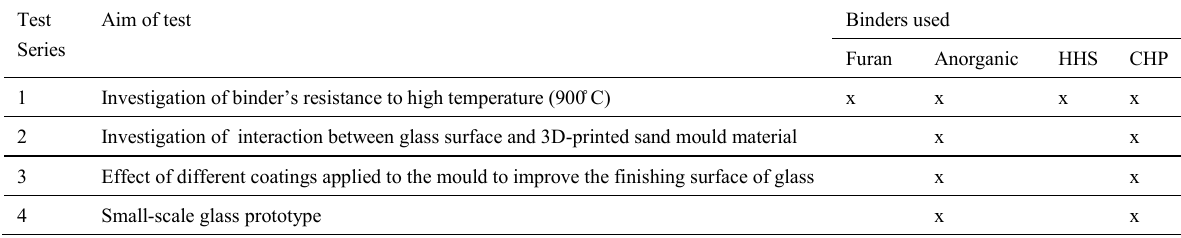
Table 2: Overview of experiments on 3D-printed sand moulds.